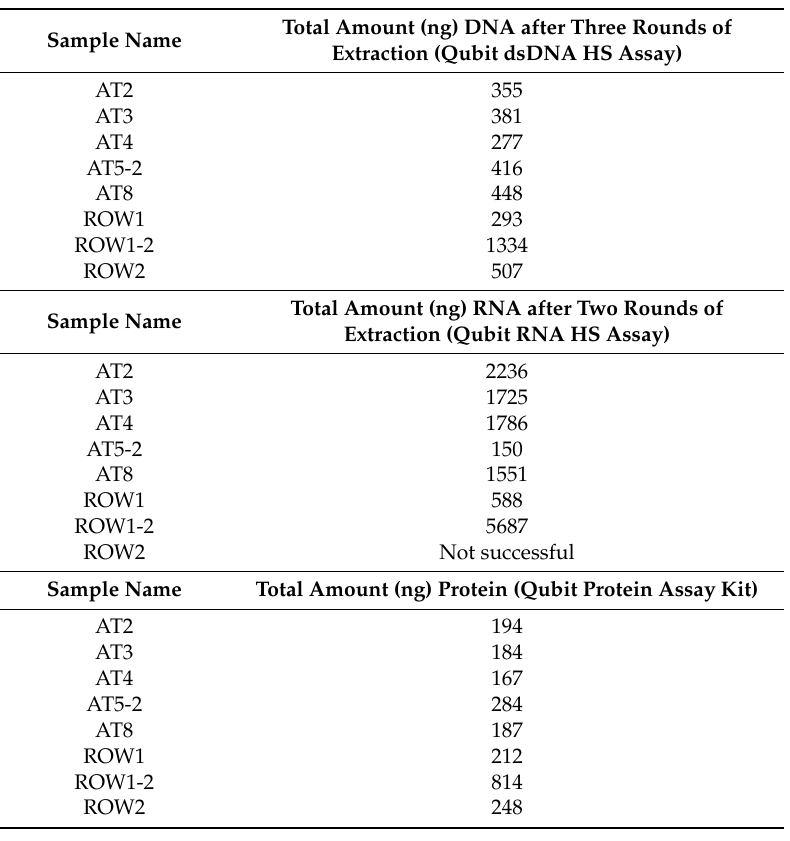
Figure 3. Bioanalyzer Eukaryote total RNA Pico graphs of all RNA extractions in this study. FU indicates Fluorescence Units, [s] indicates seconds and [nt] equals nucleotide size, which is interchangeable to seconds as larger nt fragments take longer to go through the gel. Table 1. Amounts of DNA/RNA/proteins after initial extraction.